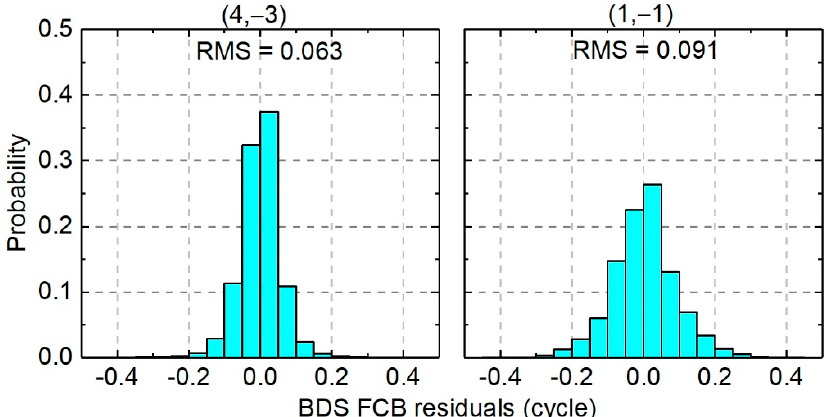
Figure 10. Distribution of the a posteriori residuals of the BDS-2 FCB estimation with integer linear-combined float ambiguities.